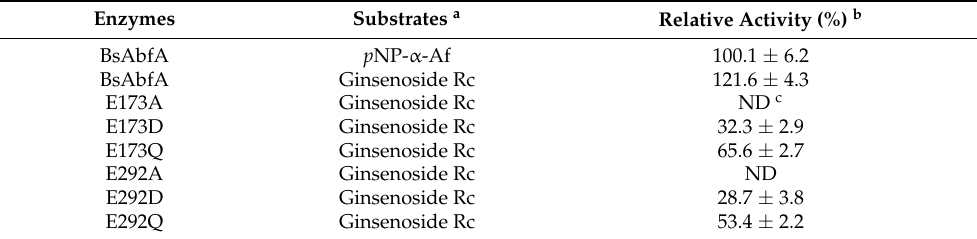
Table 1. Production of ginsenoside Rd from ginsenoside Rc by optimized and mutated BsAbfA.